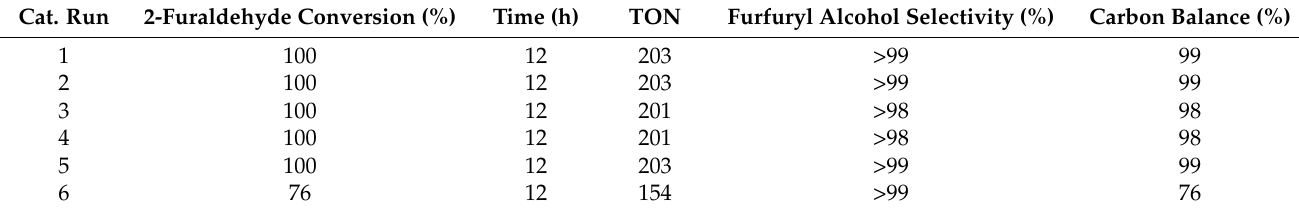
Figure 3. TEM micrographs with nanoparticle size distribution histograms (inset): Ru(0)-montmorillonite 3 prepared in water ( B ); and in ethanol ( A ). Table 1. Hydrogenation of 2-furaldehyde in water at 40 ◦ C using Ru(0)-containing montmorillonite 3. Cat.